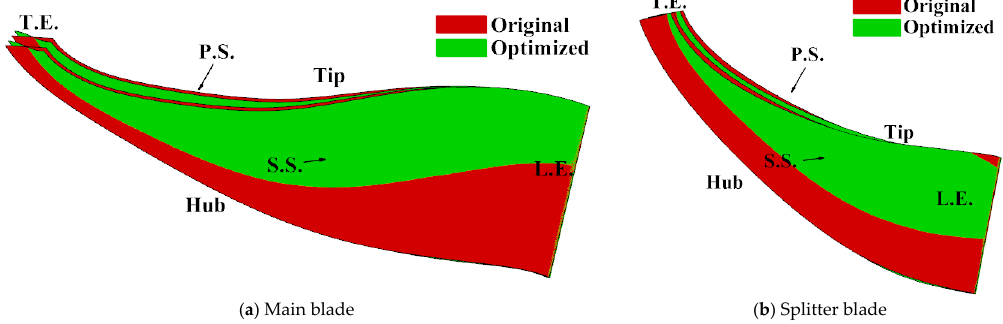
Figure 9. Comparison of impeller blade geometry before and after optimisation.